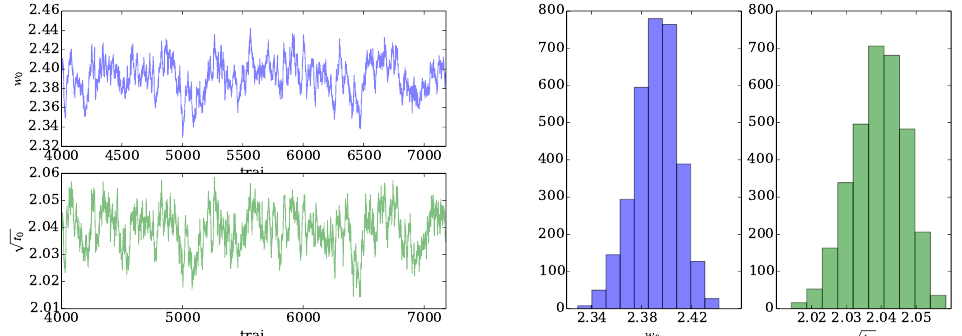
p t 0 , respectively. Right : the